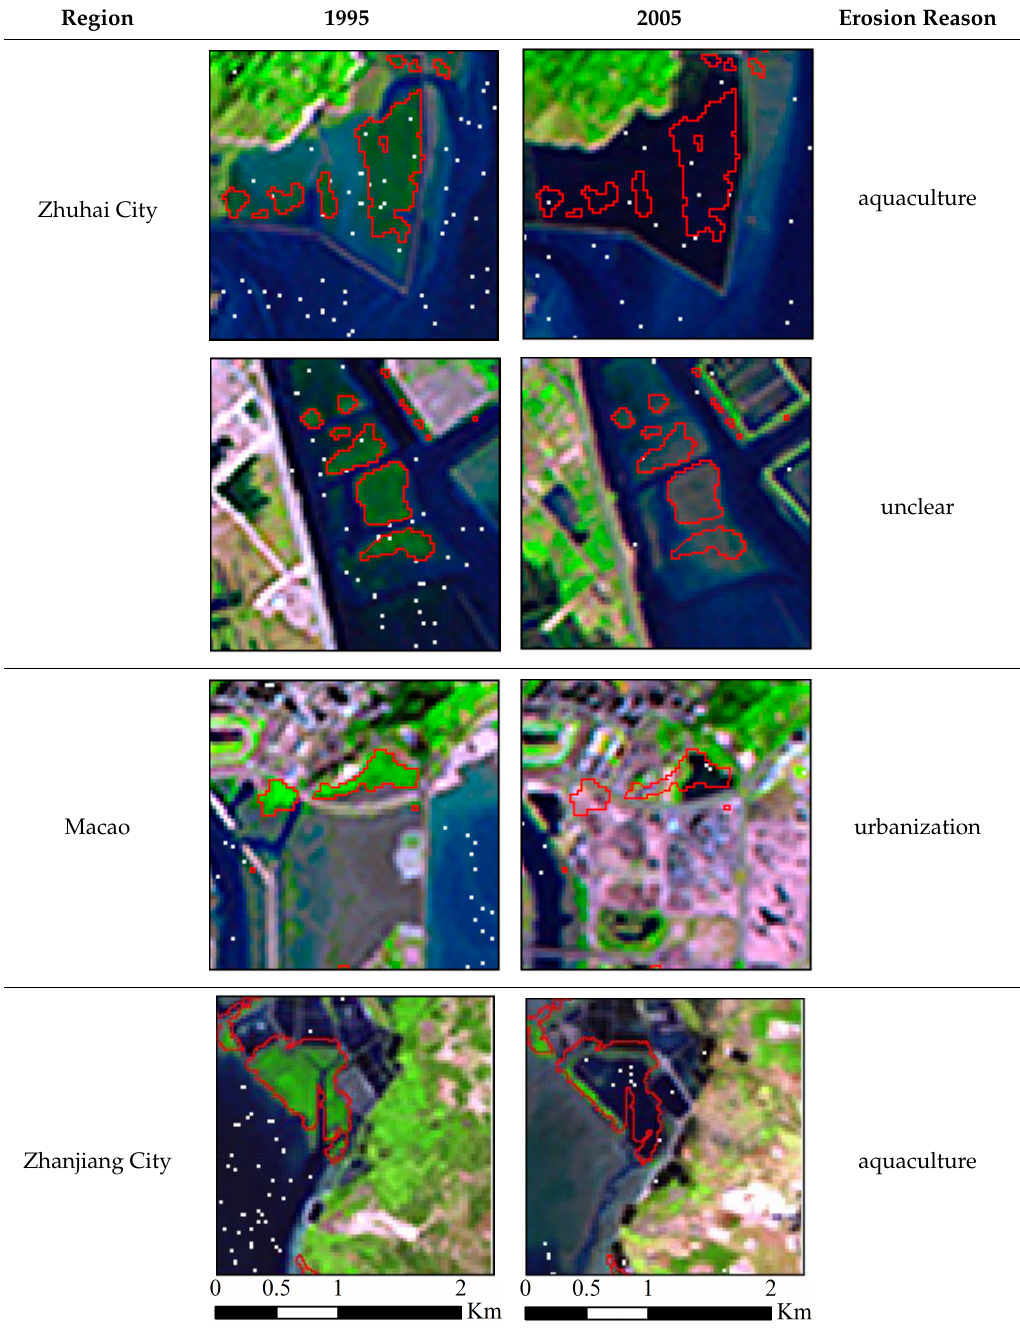
Table 4. Examples of reasons for mangrove erosion during the period from 1995 to 2005.